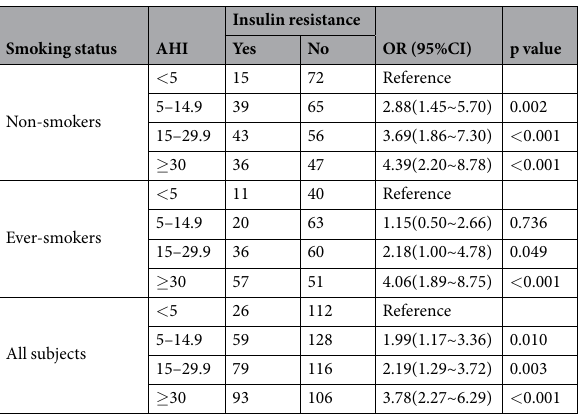
Table 4. Odds ratios of insulin resistance at different OSAS severity groups as compared to normal subjects. * p value was calculated from Pearson χ 2 test. Abbreviations: OSAS, obstructive sleep apnea syndrome; AHI, apnea-hypopnea index; CI, confidence